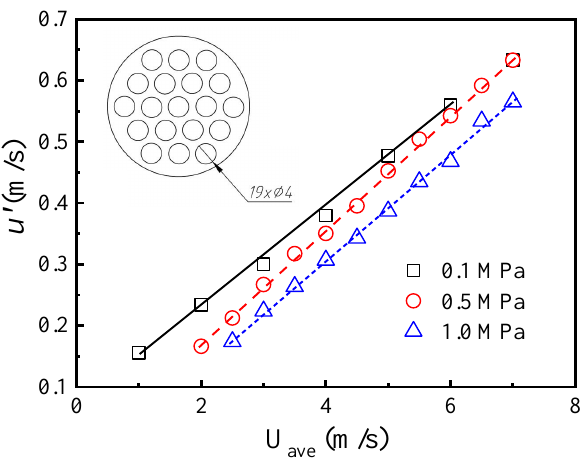
Figure 2. The schematic of the perforated plate used and the relationship between turbulence intensity and bulk inlet